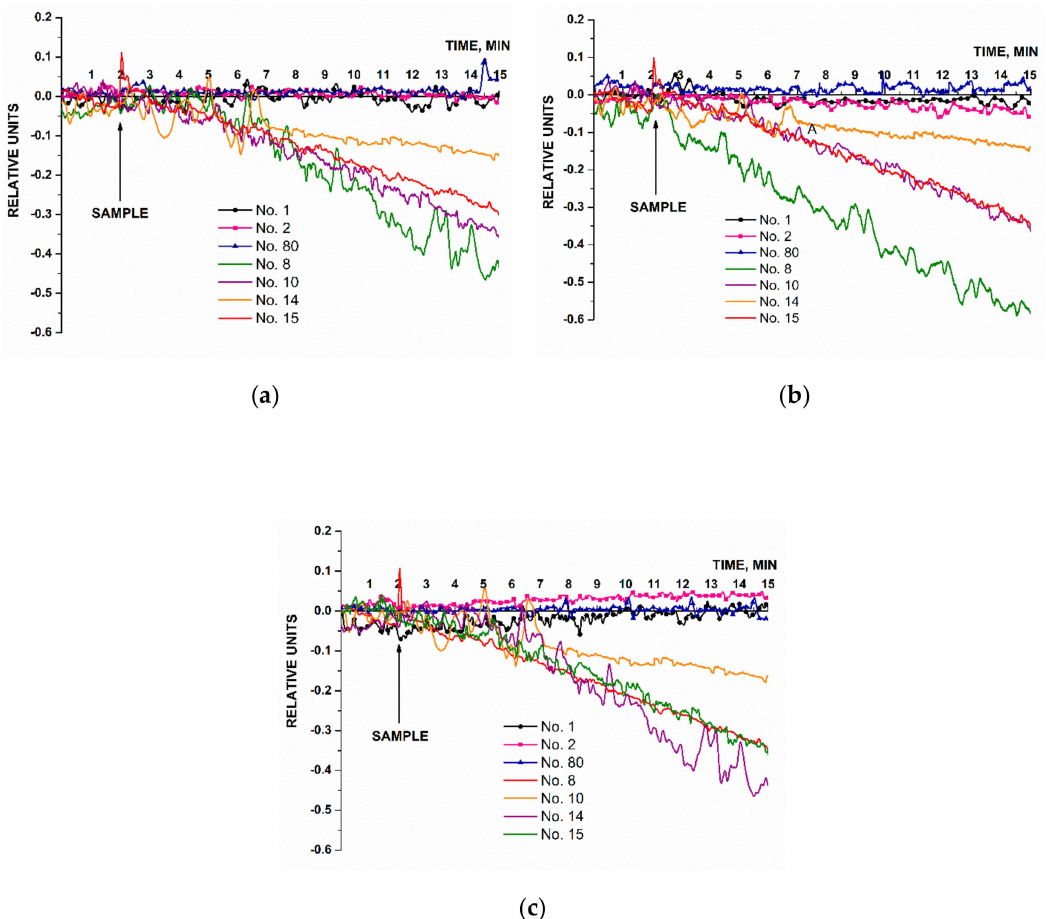
Figure 9. The results of biospecific detection of miRNAs isolated from blood plasma samples. Experimental conditions: SOI-NW chip with n-type conductivity; nanowires with immobilized oDNA probes: probe_1 ( a ), probe_2 ( b ), and probe_3 ( c ); 1 mM PPMB; V g = 50 V, V ds = 0.2 V; liquid volume in the measuring cell was 107 µ L. Analyzed samples: samples No. 8, No. 10, No. 14, and No. 15 isolated from blood plasma of patients with ovarian cancer (olive, purple, orange, and red curves without markers); control sample No. 80 isolated from the plasma sample collected from a patient with breast cancer (blue curve, triangles); control samples No. 1 and No. 2 isolated from plasma samples collected from healthy volunteers (black curve, circles and pink curve, squares, respectively). The arrow indicates the time point when the analyzed solution containing isolated miRNAs was